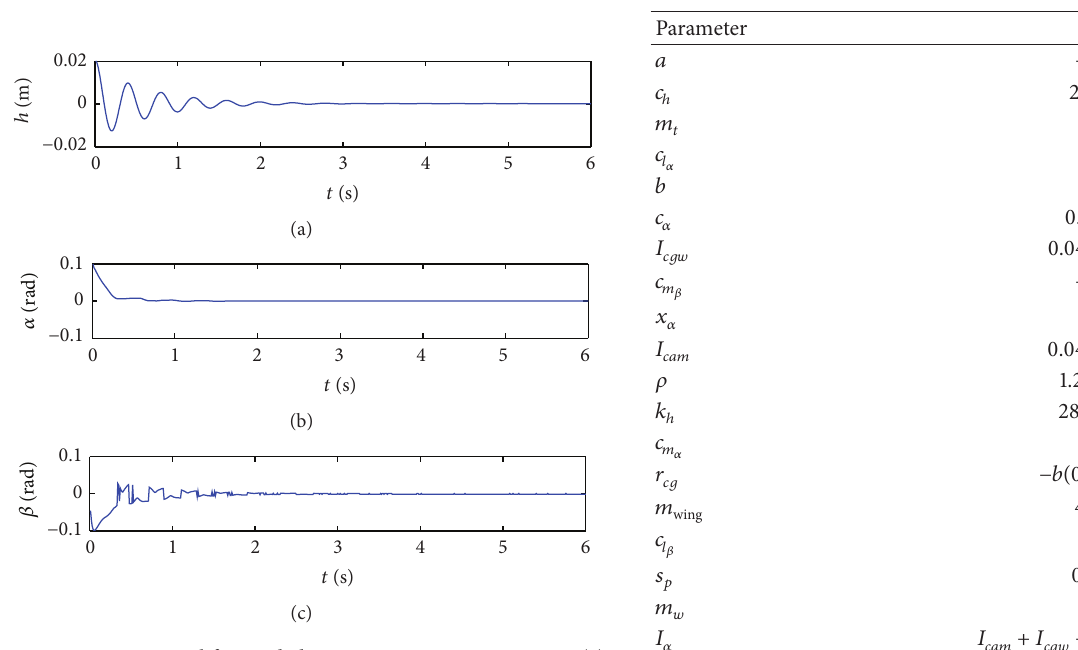
Figure 6: ILC control for sinusoidal gust, 𝑤 0 = 0.07 , 𝑈 = 16 m/s: (a) plunge displacement ℎ (m); (b) pitch angle 𝛼 (rad); (c) control input 𝛽 (rad).